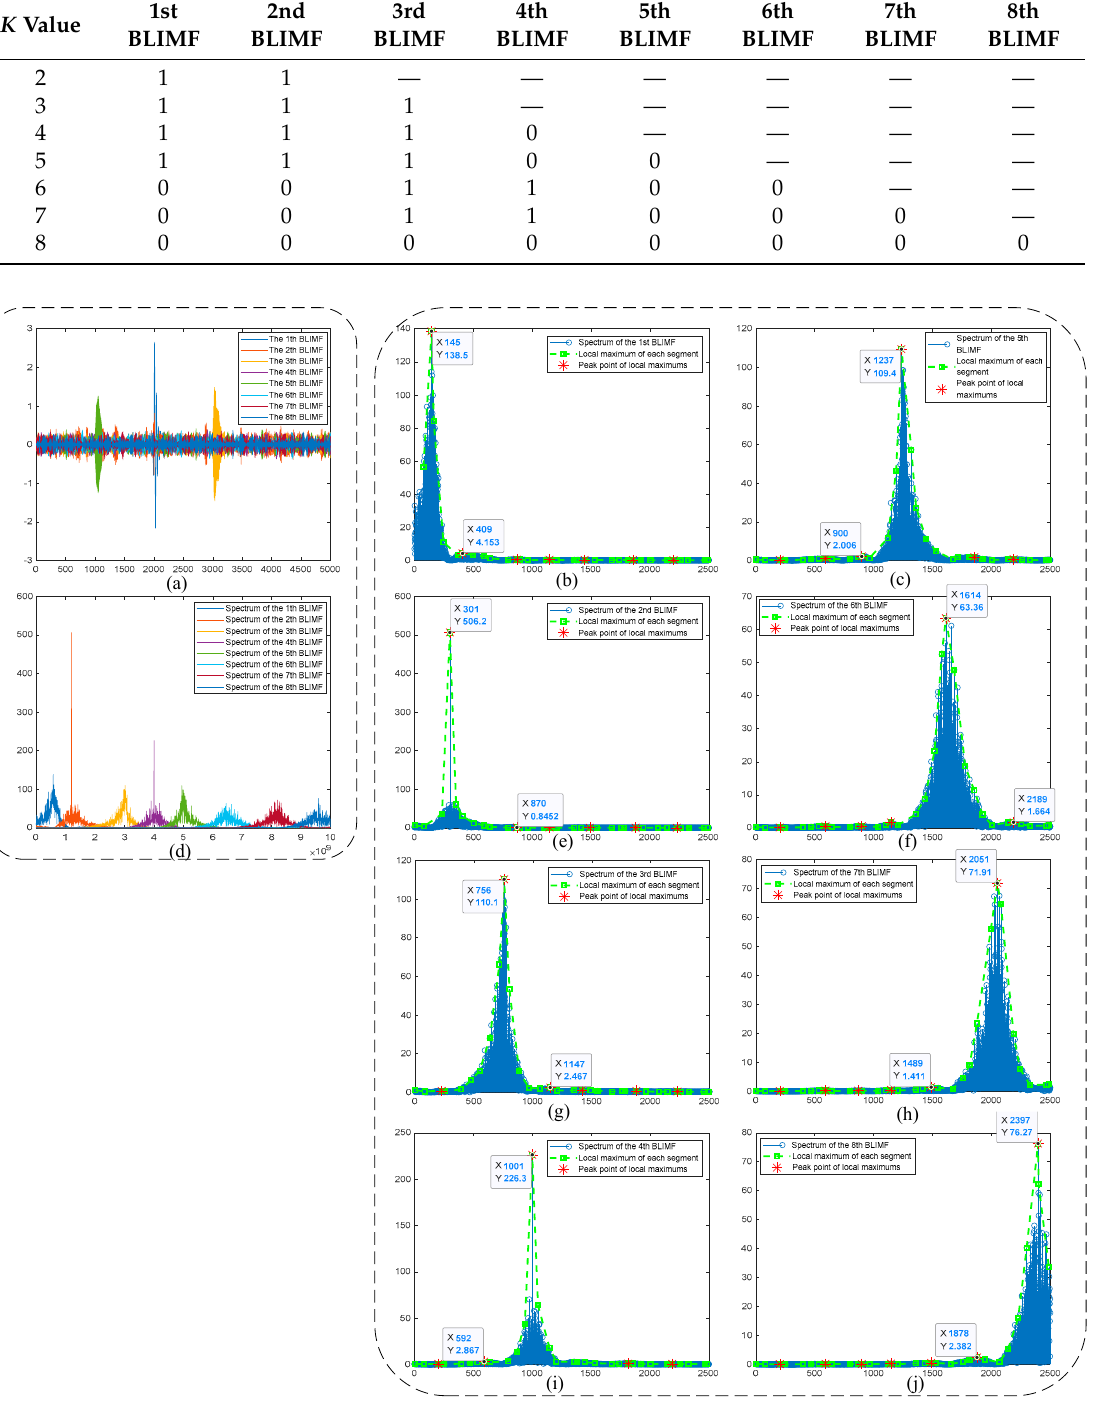
Figure 5. Optimization process when k = 8: ( a ) Time-domain waveforms of BLIMFs; ( b )–( c ) Local maximums of 1st and 5th BLIMFs and their peak points; ( d ) Spectra of BLIMFs; ( e )–( j ) Local maximums of 2nd, 6th, 3rd, 7th, 4th, 8th BLIMFs and their peak points.